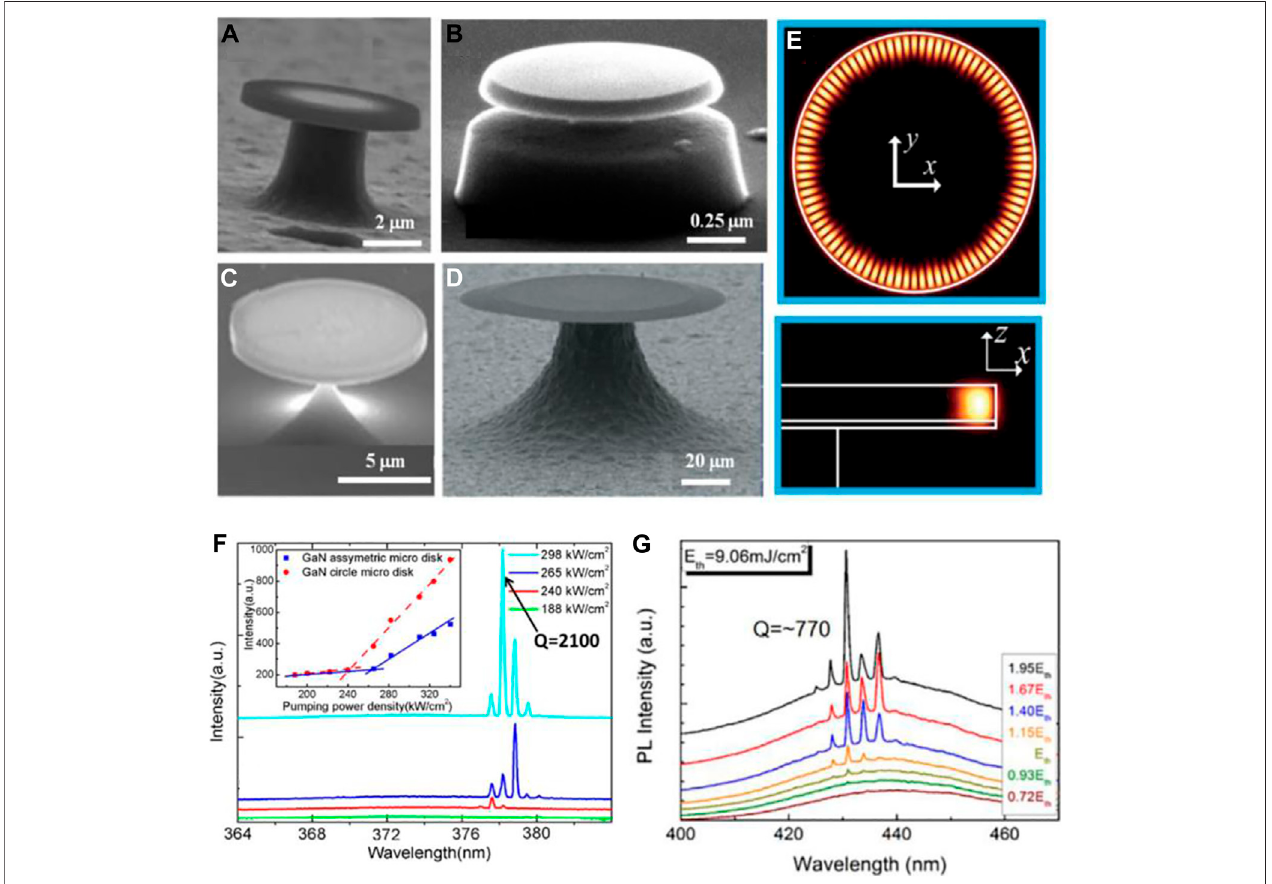
FIGURE 3 | (A – D) GaN microdisk cavity lasers with various morphologies (Yan et al., 2009; Zhang X et al., 2014; Bogus ł awski et al., 2018; Liu et al., 2019); (E) WGM lasing simulation results of microdisk cavities; (F) lasing spectra of the GaN microdisk in the UV region; (G) lasing spectra of the GaN microdisk in the blue region (Zhang X et al., 2014; Zhu et al., 2017). Reprinted with permission © AIP Publishing (Yan et al., 2009; Zhu et al., 2018).